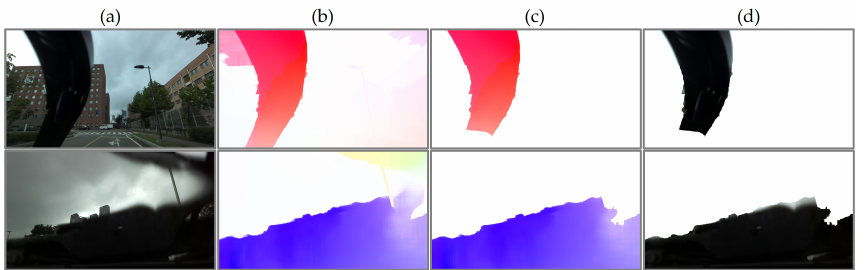
Figure 8. Pseudo-ground truth generation: ( a ) original images; ( b ) predicted optical flow by auto- labeling; ( c ) threshold filtered flow; ( d ) extracted RGB masks.